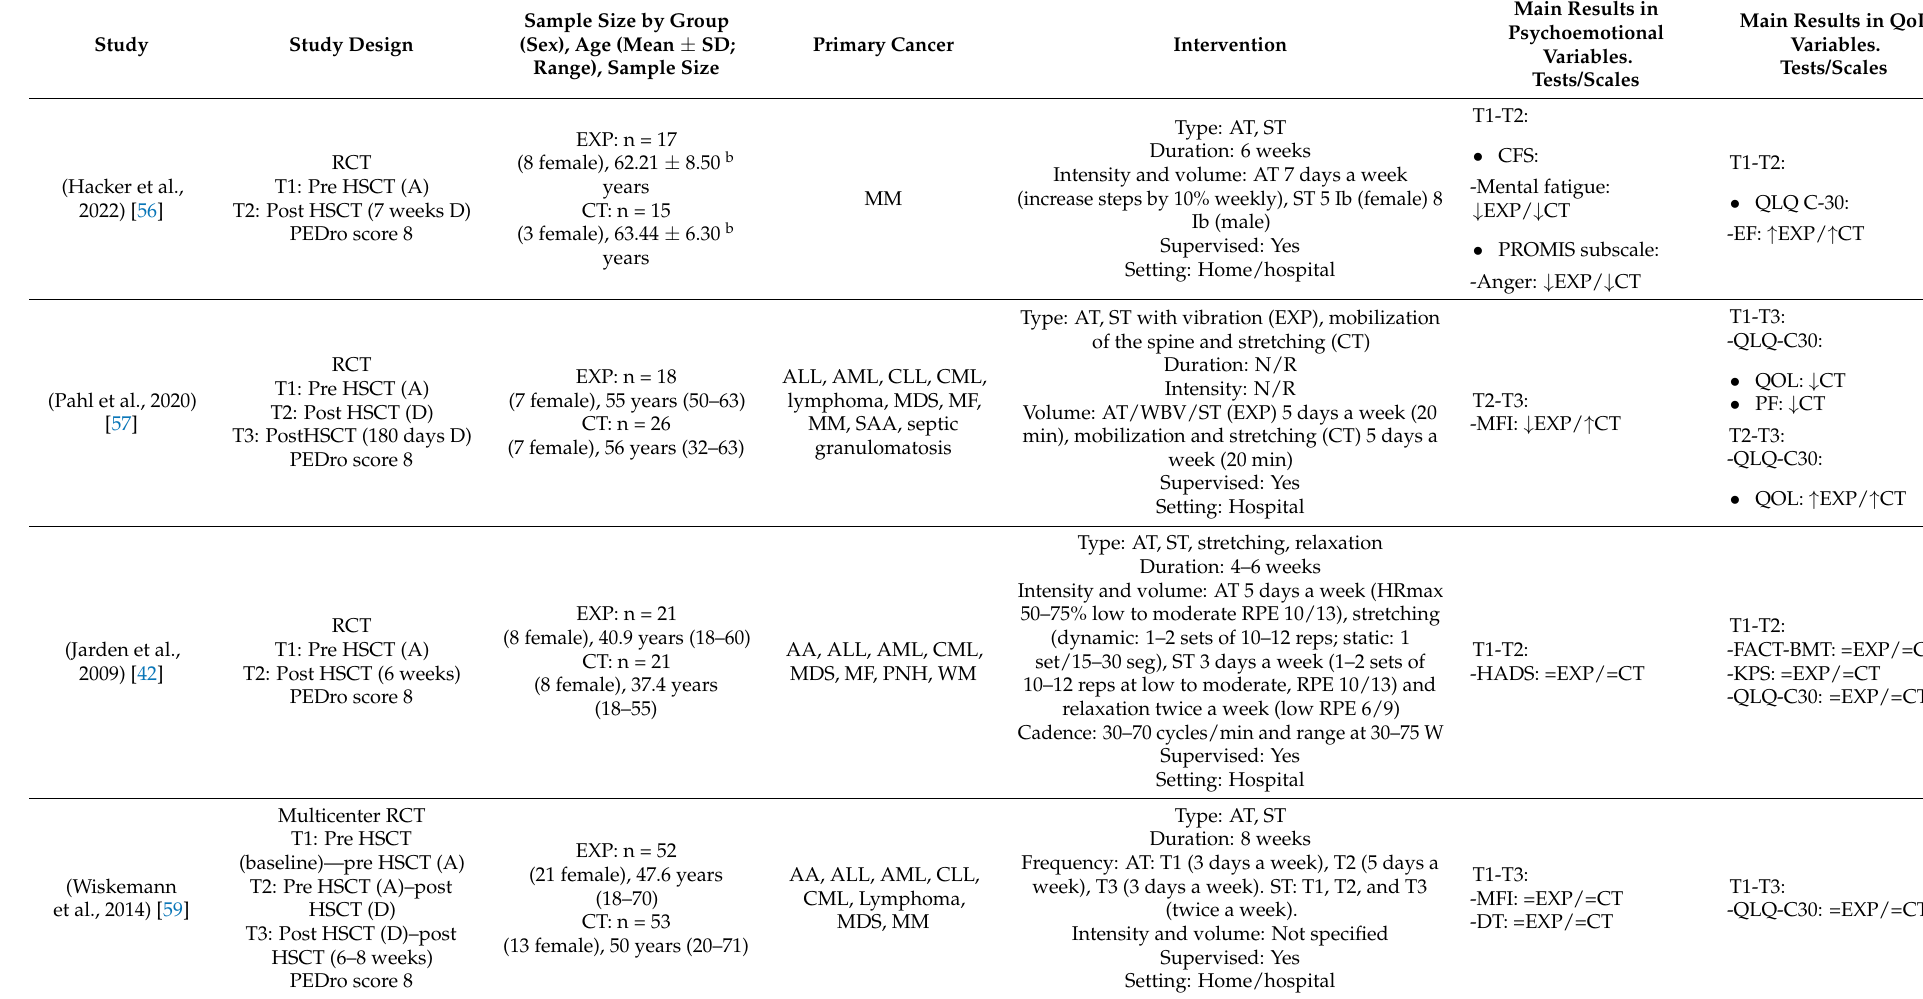
Table 2. Studies that have analyzed the effects of an exercise program before and after HSCT, with the main results in quality of life and other psychoemotional-related variables. (All the studies were ordered by PEDro score from largest to